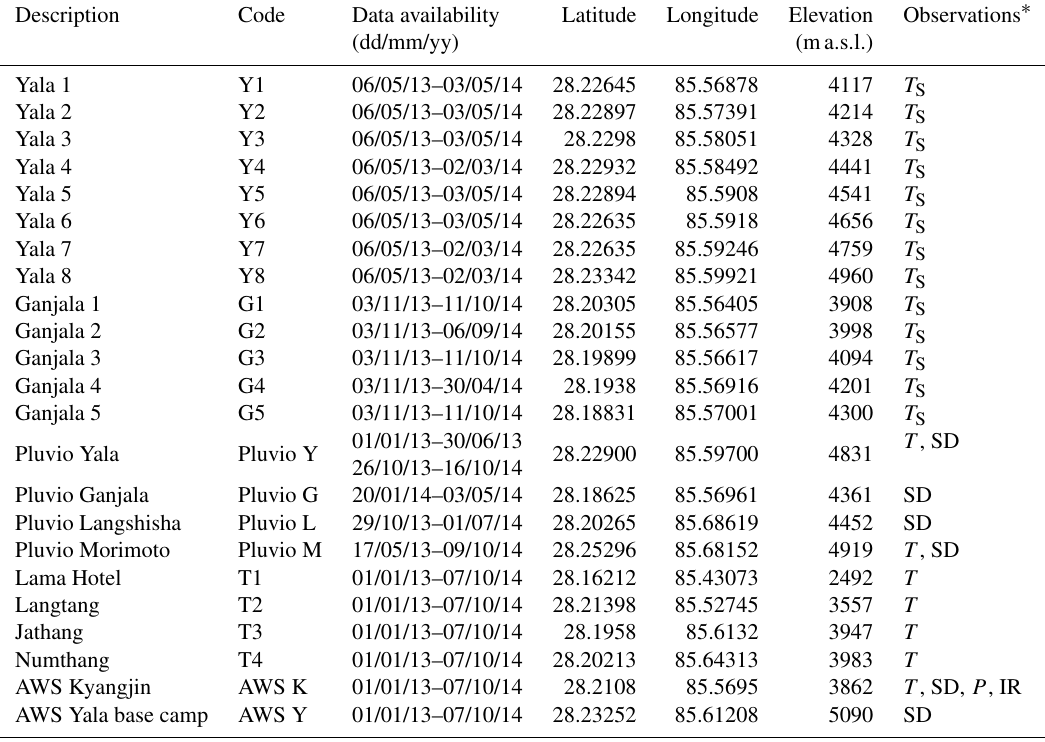
Table 1. Overview of the in situ observations and their specifications. Locations are shown in Fig.